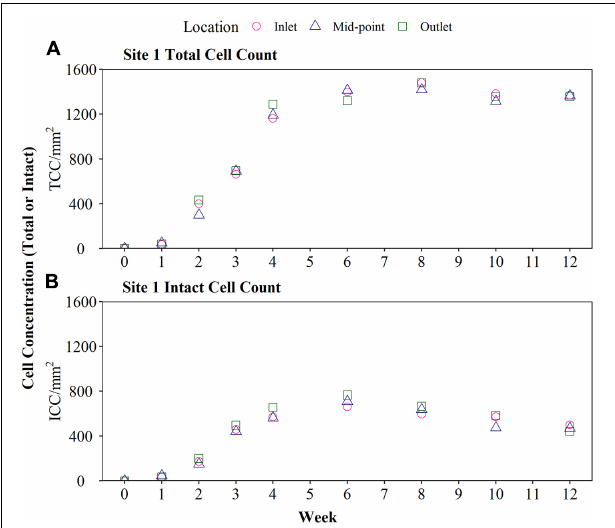
FIGURE 3 | Verification of biofilm monitoring device (BMD) installed at Site 1 for 12 weeks in October. Biofilm cell count data, including total (TCC) and intact cell count (ICC), obtained from BMD are presented (raw data plotted including sampling from the inlet, mid-point, and outlet of the BMD). The BMD was installed horizontally and operated with a flow rate of 1